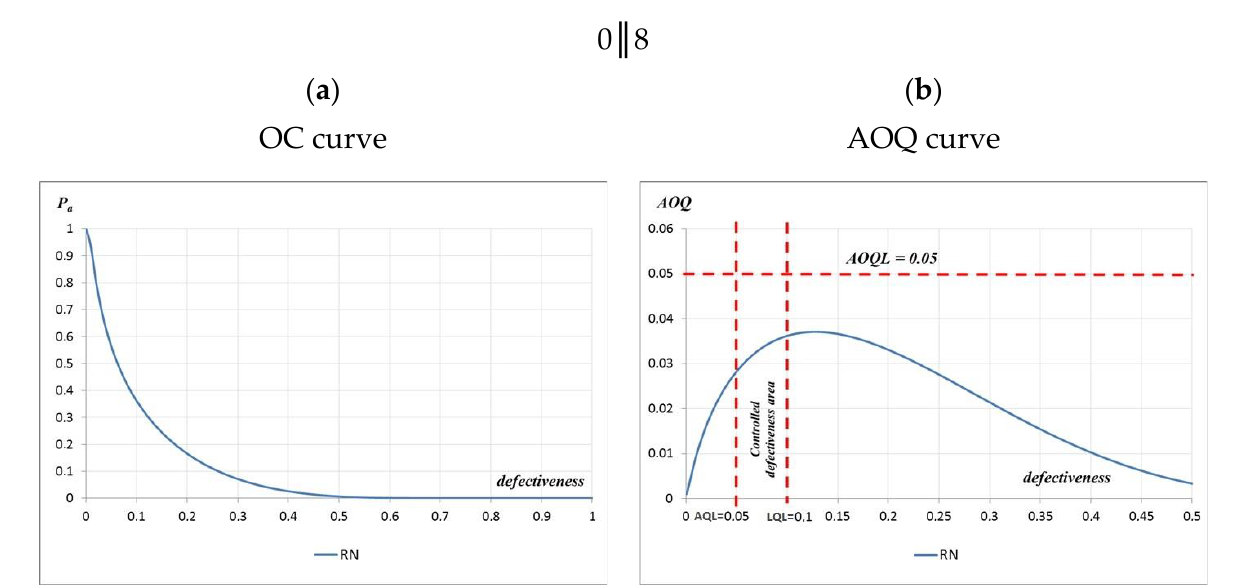
Figure 19. OC and AOQ curves for testing plan: (a) 0 ║ 8 and (b) 0 ║ 8.